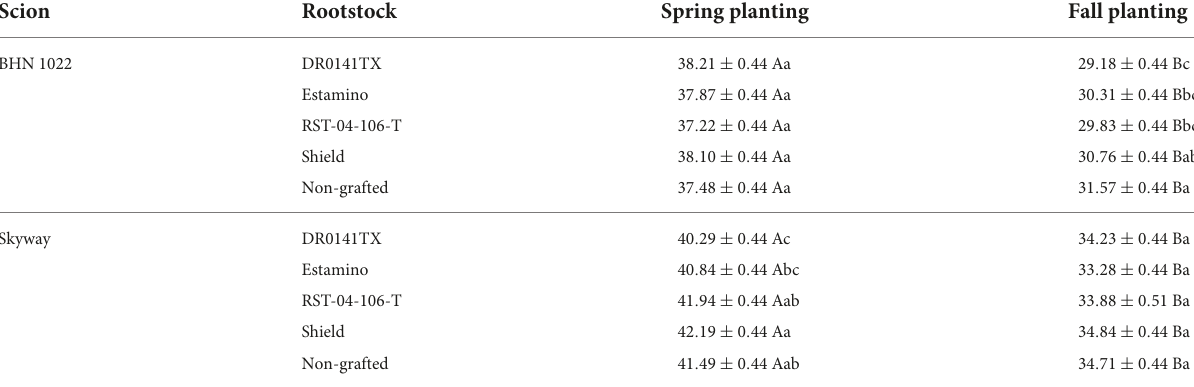
TABLE 3 Fruit C * (chroma) values of fruit from grafted beefsteak tomato ‘Skyway’ and grape tomato ‘BHN 1022’ in Spring and Fall plantings.